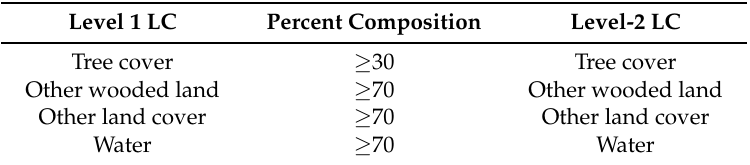
Table 2. Level-2 segment labelling rules for the automated land cover classification. Level-2 labels were based on the areal proportion of component level-2